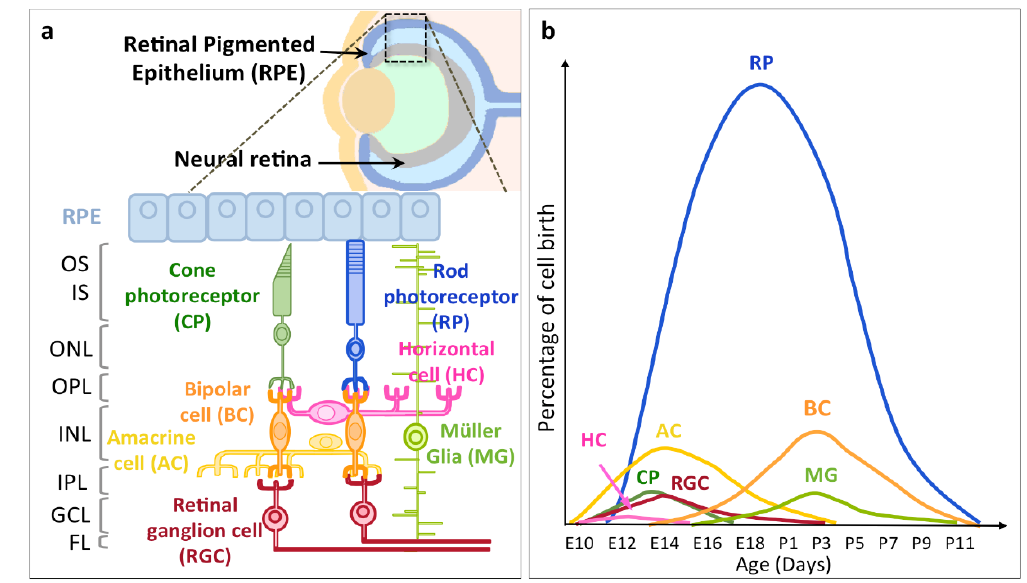
Figure 1. Layer distribution and genesis of the different retinal cell types. ( a ) Schematic representation of the eye with an enlargement on the neural retina and the retinal pigmented epithelium (RPE) showing all the retinal cell types and their organization into layers. Inner segments (IS) and outer segments (OS) of photoreceptors. The outer nuclear layer (ONL) contains soma of cone photoreceptors (CP) and rod photoreceptors (RP). OPL: outer plexiform layer. The inner nuclear layer (INL) contains soma of Müller glia (MG) and different interneurons: amacrine cells (AC), horizontal cells (HC) and bipolar cells (BC). IPL: inner plexiform layer. The ganglion cell layer (GCL) contains retinal ganglion cells (RGC). The fiber layer (FL) contains RGC axons. Adapted from Cepko et al., 2014 [19]. ( b ) Time course of differentiation of the retinal cells generated during mouse development illustrating the early differentiation of postmitotic RGCs. E: embryonic days, P: postnatal days. Adapted from Young et al., 1985 [12].